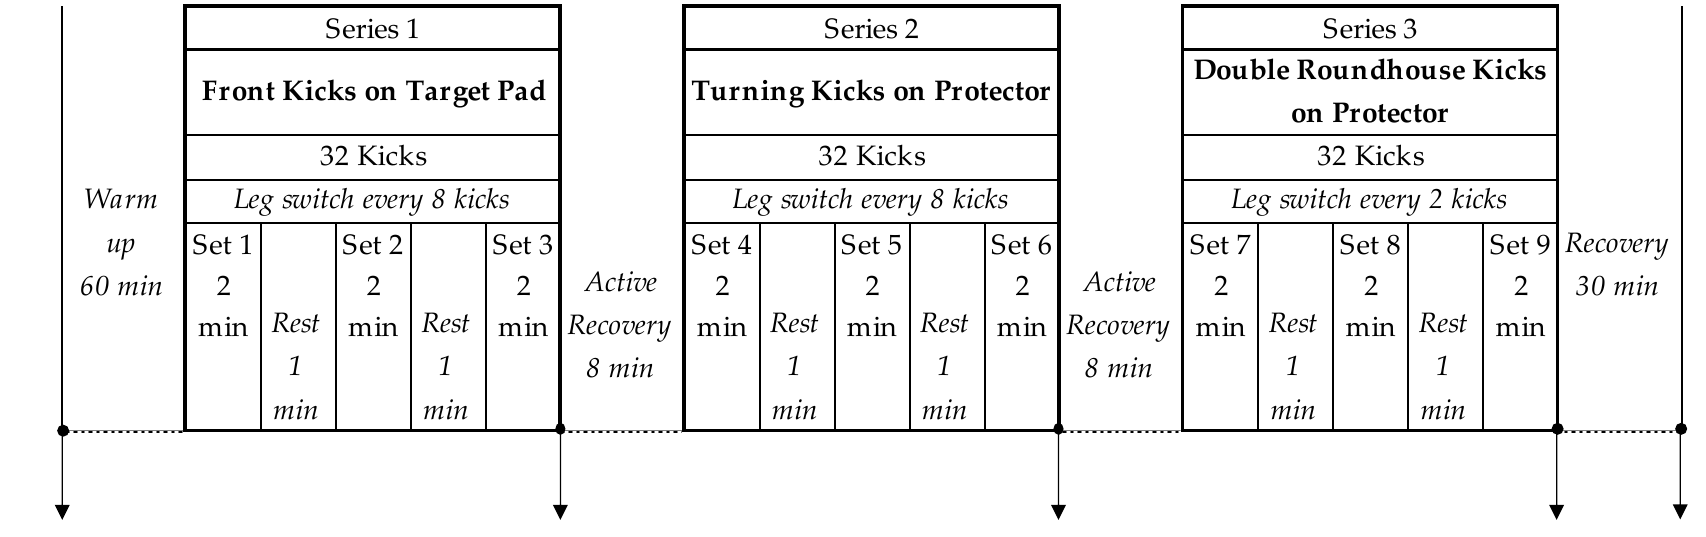
Figure 1. The structure of the analyzed taekwondo-specific circuits. Vertical downward arrows denote blood sampling.